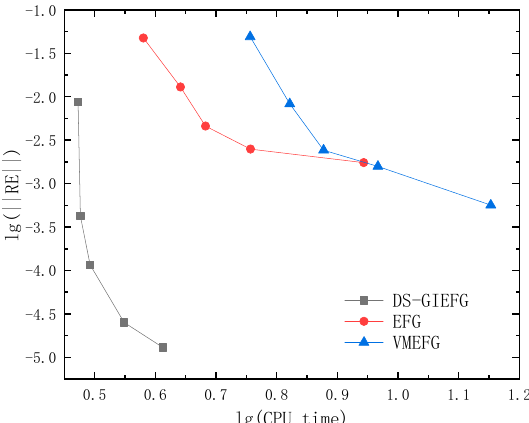
[0,1] [0,1] Ω = × with the